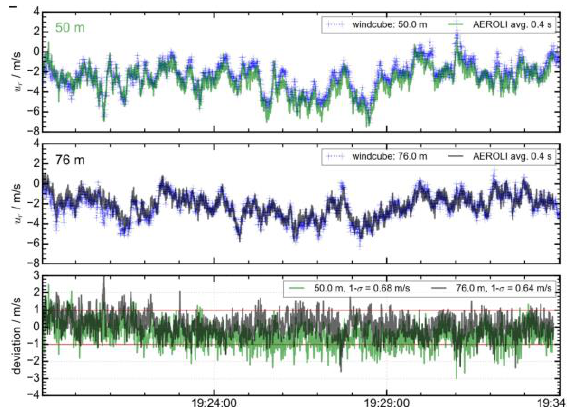
Figure 3: Exemplary horizontal wind measurement time series of the FWFIMI-DWL, bias removed, compared to Windcube ® 200S data, both averaged to 2.5 Hz rate at center ranges 50 and 76 m. Lower panel: Respective deviations between the